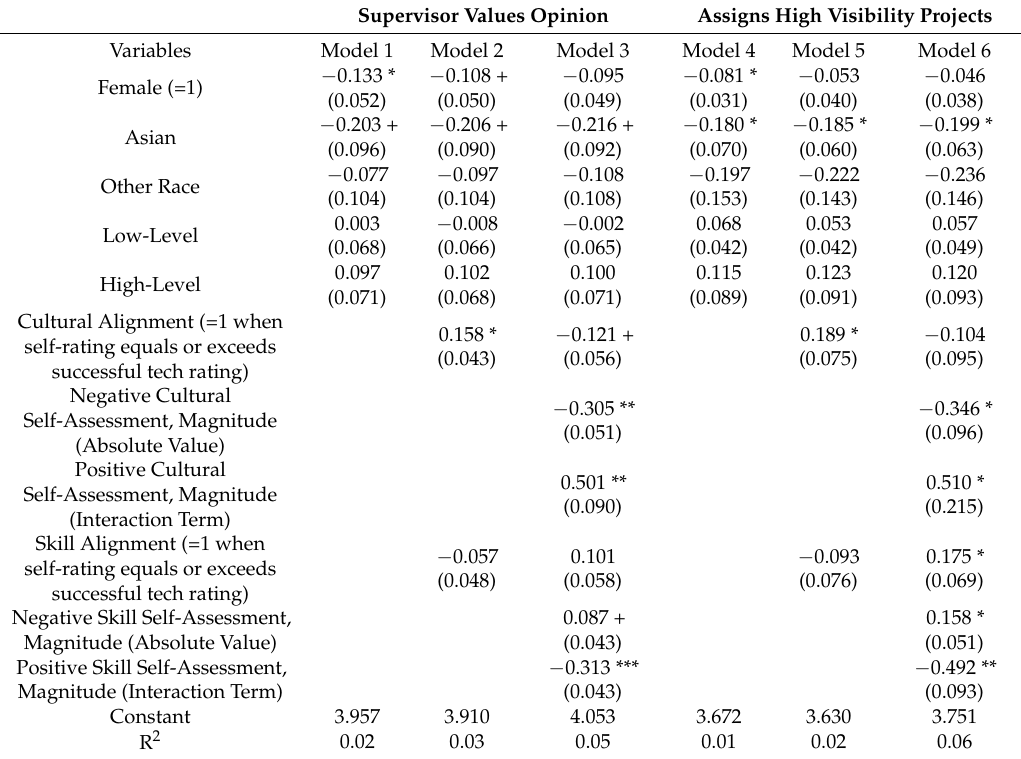
Table 3. OLS Regression Estimates for the Effects of Cultural and Skill Alignment on Perceived Supervisor Treatment of Silicon Valley Tech